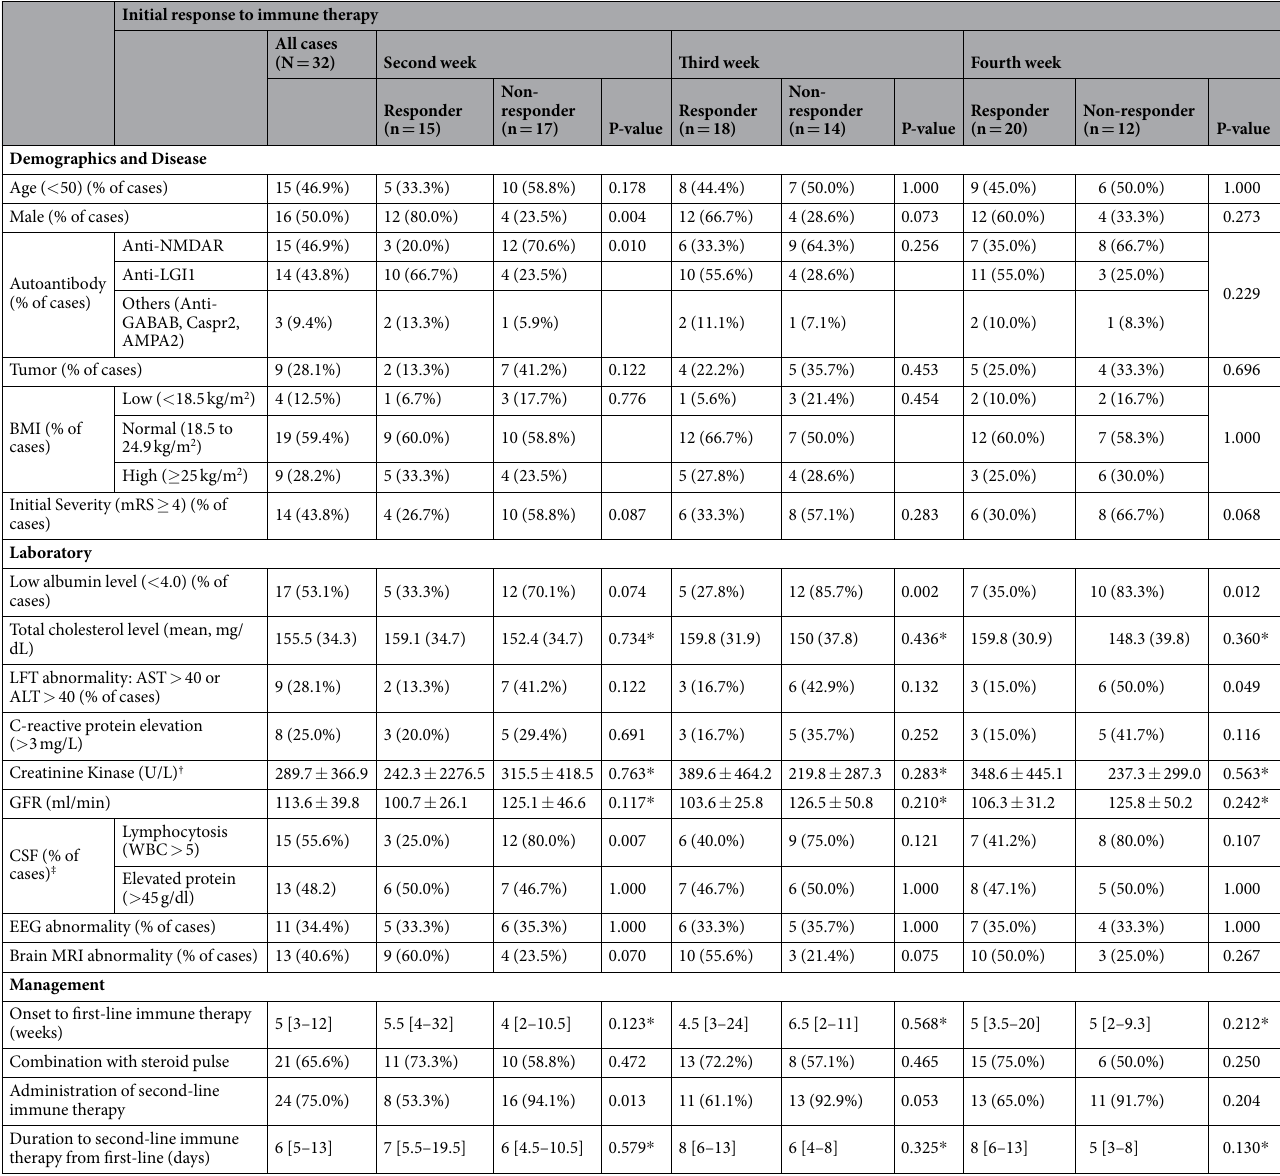
Table 2. Factors associated with prognosis. NMDAR = N-methyl D-aspartate receptor; LGI1 = leucine- rich glioma inactivated 1; GABAB = γ -aminobutyric acid B; Caspr2 = contactin-associated